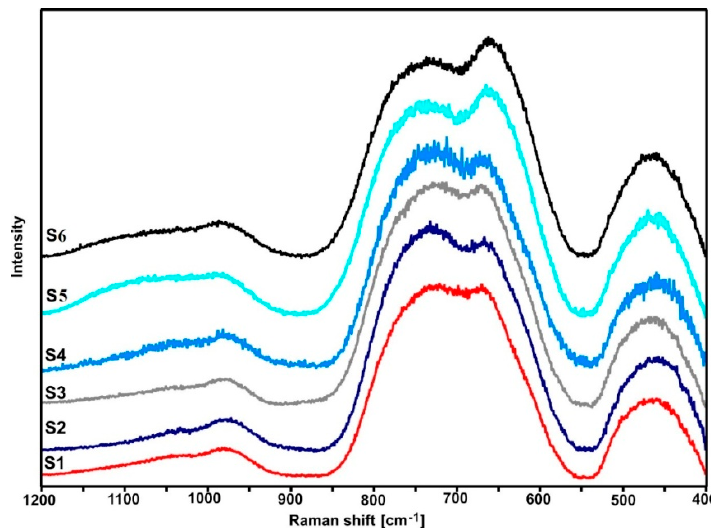
Figure 4. Normalized Raman spectra of S1–S6 glasses.